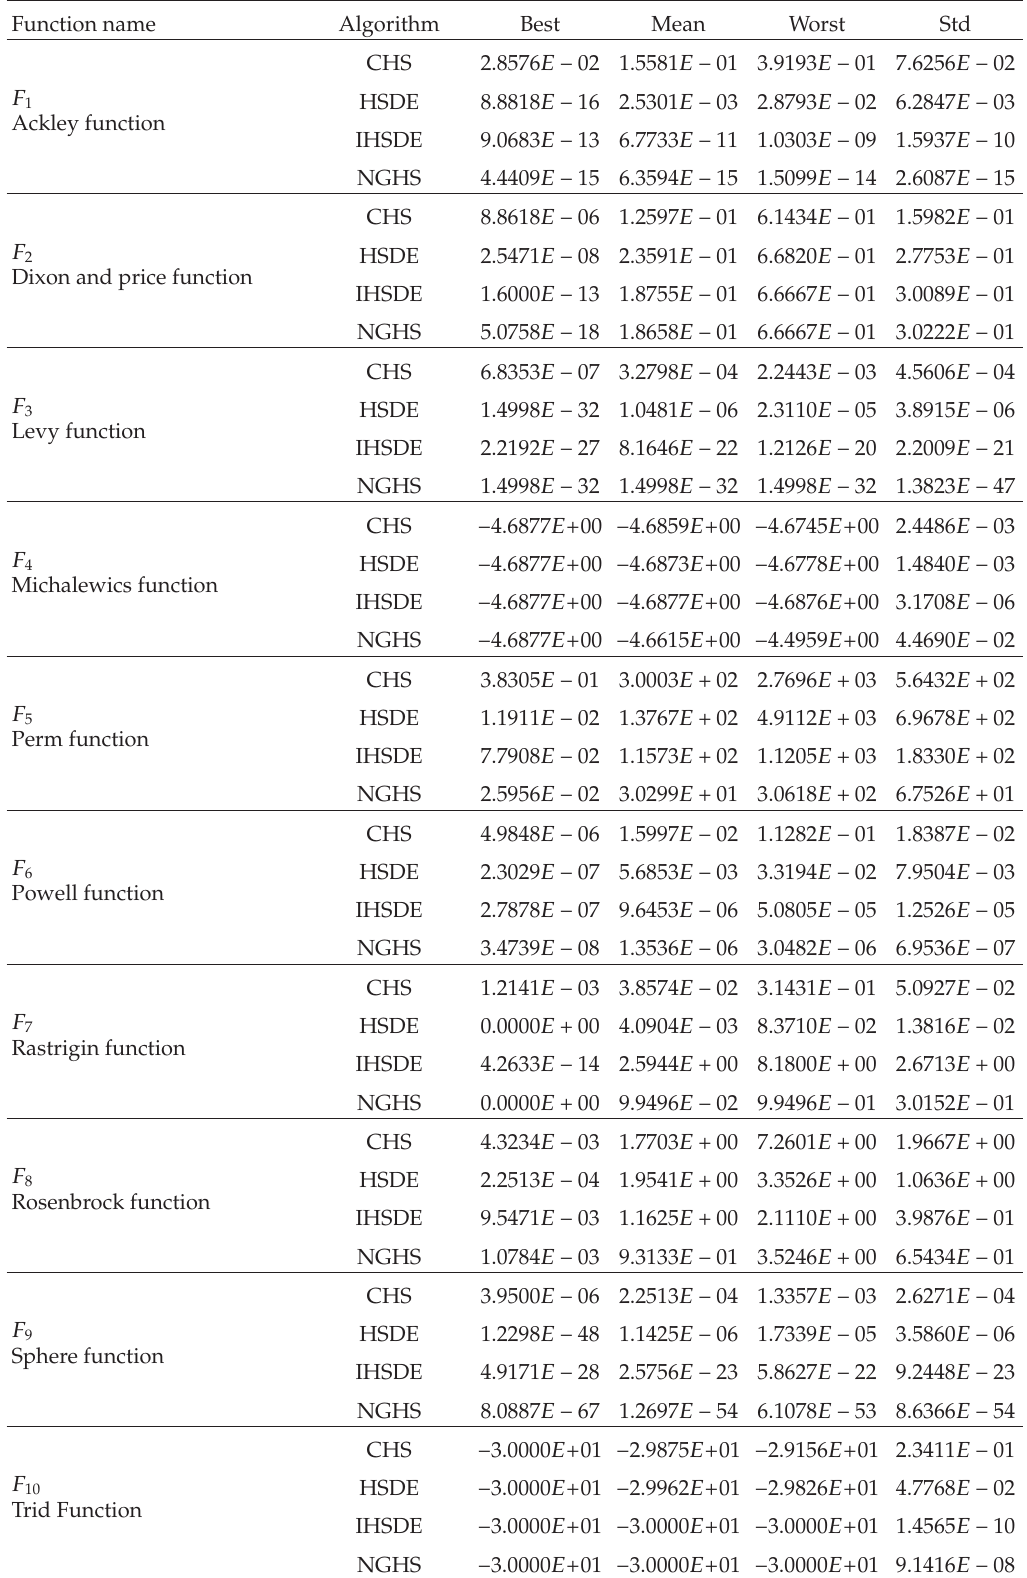
Table 2: The statistical results for 50 runs tested on sixteen benchmark